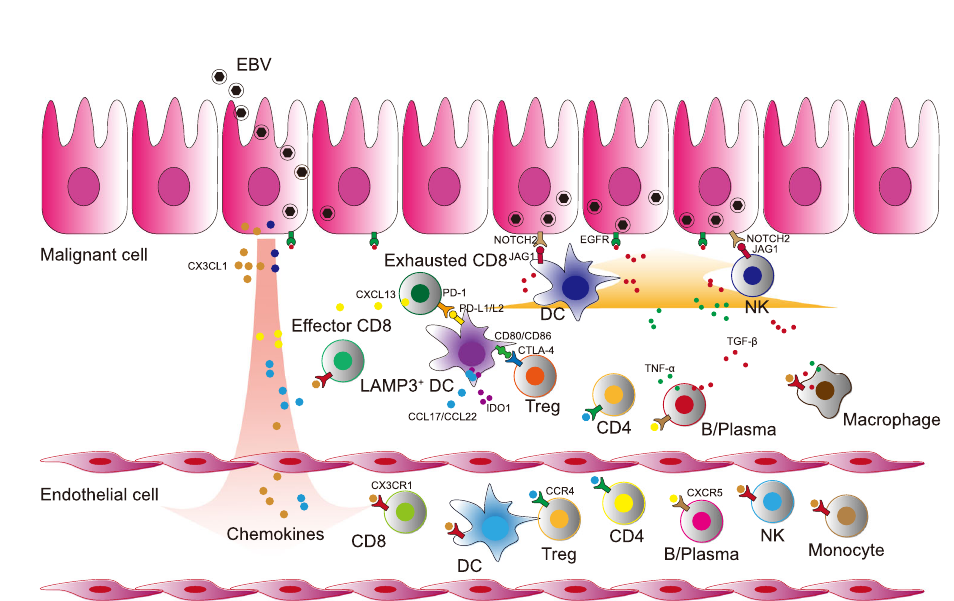
Fig. 7 Schematic diagram of cross-talks among multiple immune cells in the TME of NPC. EBV infects nasopharyngeal epithelial cells and participates in the tumorigenic process of NPC. EBV-positive malignant NPC cells secret a variety of chemokines (CX3CL1, etc.) and initiate the recruitment and tumoral in fi ltration of multiple immune cells with the chemokines receptors from the peripheral blood. Multiple tumour in fi ltrating immune cells activate EGFR and Notch pathway in EBV-positive malignant NPC cells. Naive CD8 + cells in fi ltrate to the lesion and develop to effector and further exhausted CD8 + cells. Peripheral DCs in fi ltrate to the tumour and differentiate into LAMP3 + DCs. The mature LAMP3 + DCs with the expression of PD-L1/PD-L2 interact with PD1 on CD8 + T cells whereby the signalling restrains the activation of CD8 + T cells and promotes their exhaustion. Treg cells interact with LAMP3 + DCs through CTLA4-CD80/CD86, which might limit the antigen presentation process of DCs and promote the secretion of IDO1 to induce the proliferation of Treg cells. The intensive cell-cell interactions among LAMP3 + DCs, Treg cells, exhausted CD8 + T cells, and malignant cells foster an immune-suppressive niche for the tumour microenvironment